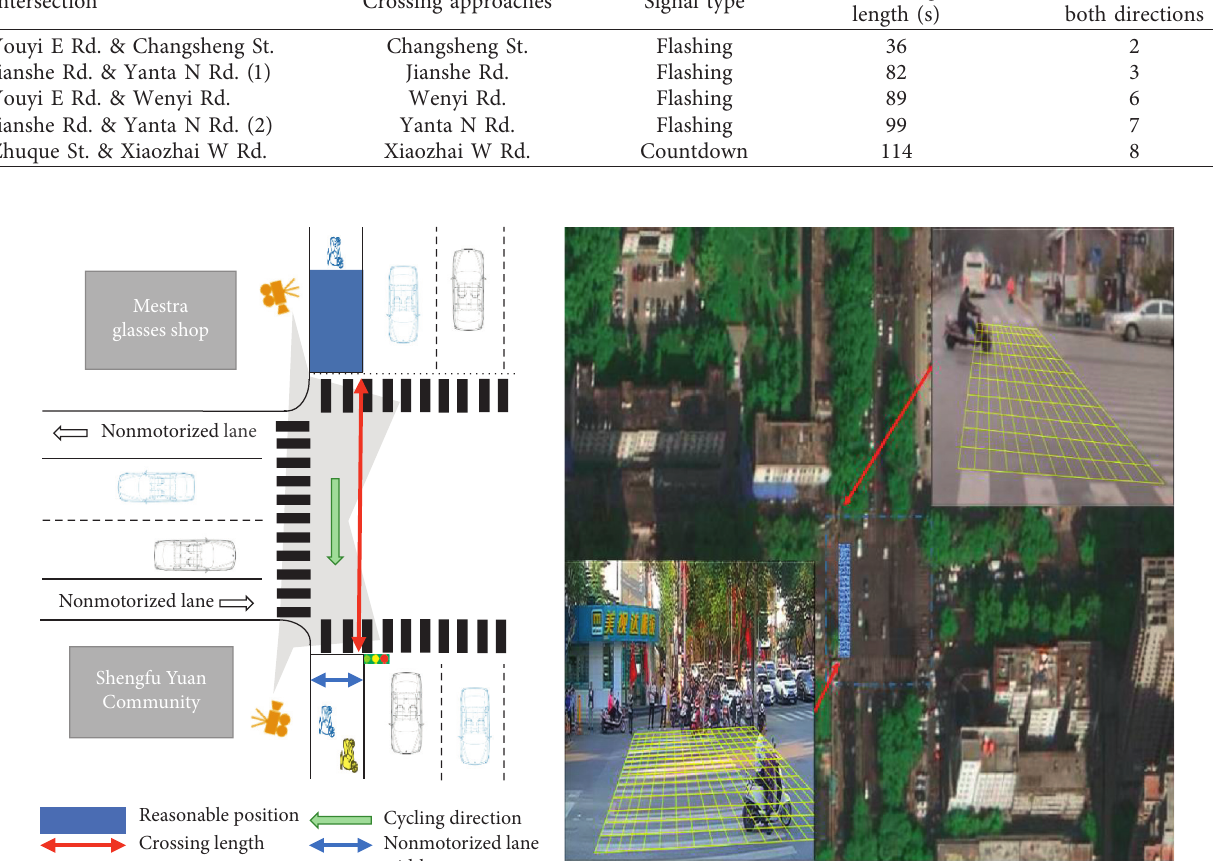
Figure 3: Schematic diagram of signalized intersection shooting (Zhuque St. & Xiaozhai W Rd.). The basemap of the right half is from AutoNavi, and the two screenshots are taken from the roadside